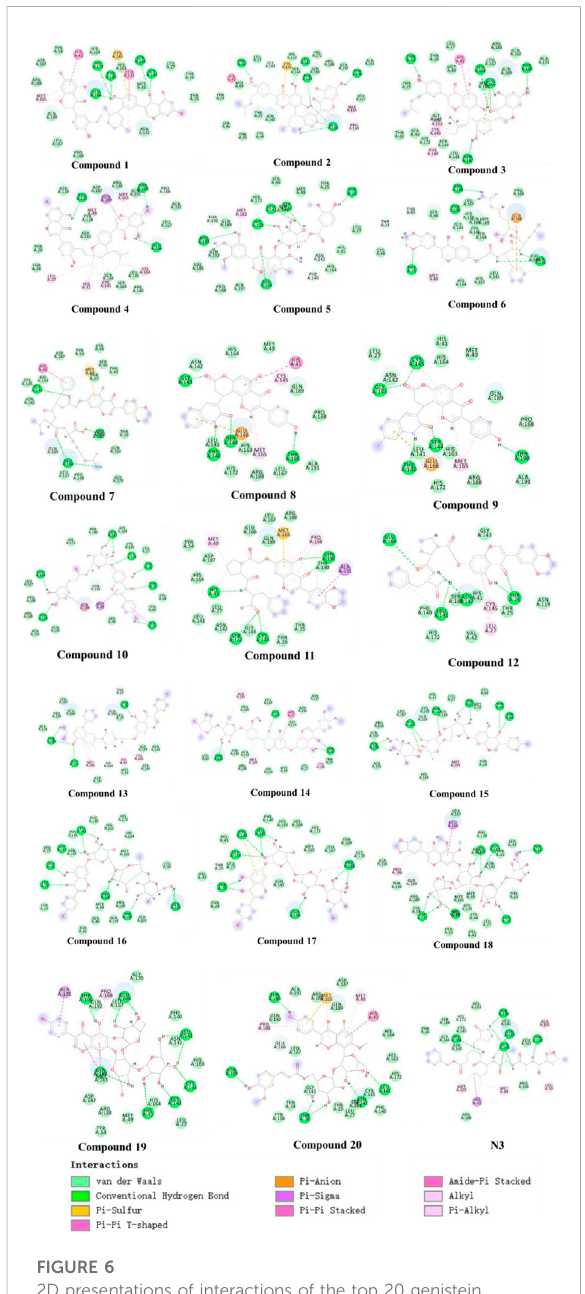
FIGURE 6 2D presentations of interactions of the top 20 genistein derivatives and N3 with SARS-CoV-2 main protease,